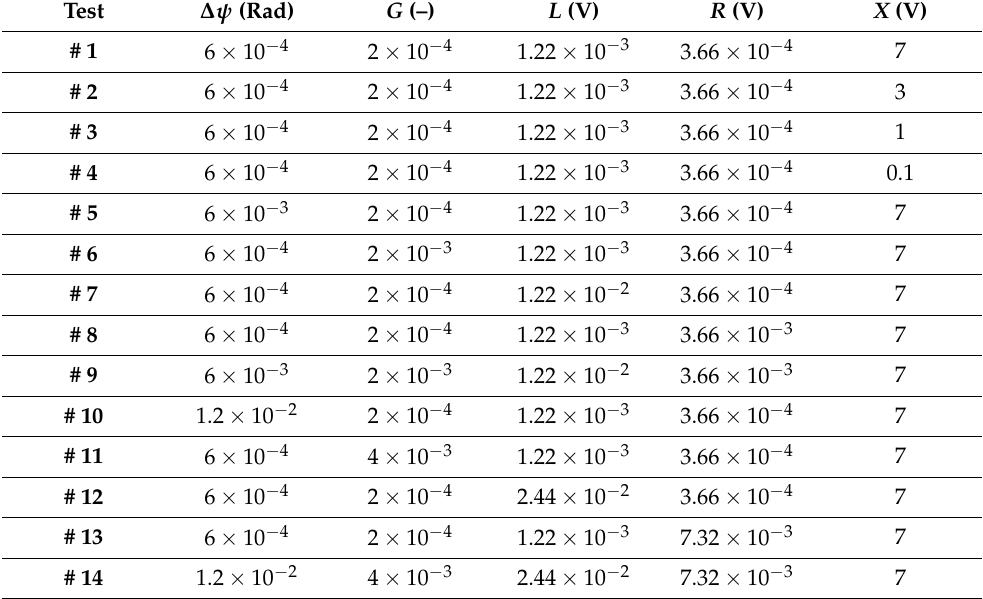
Table 2. List of the tests performed with the